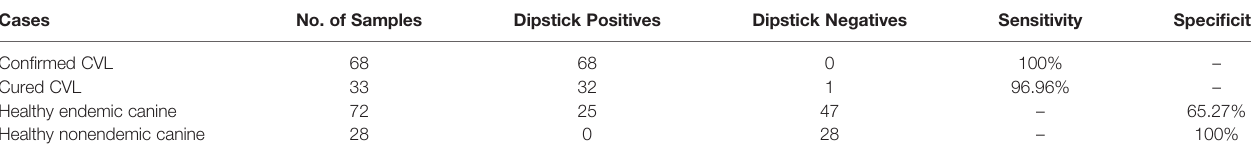
TABLE 4 | Performance of dipstick test at University of Naples, Italy.